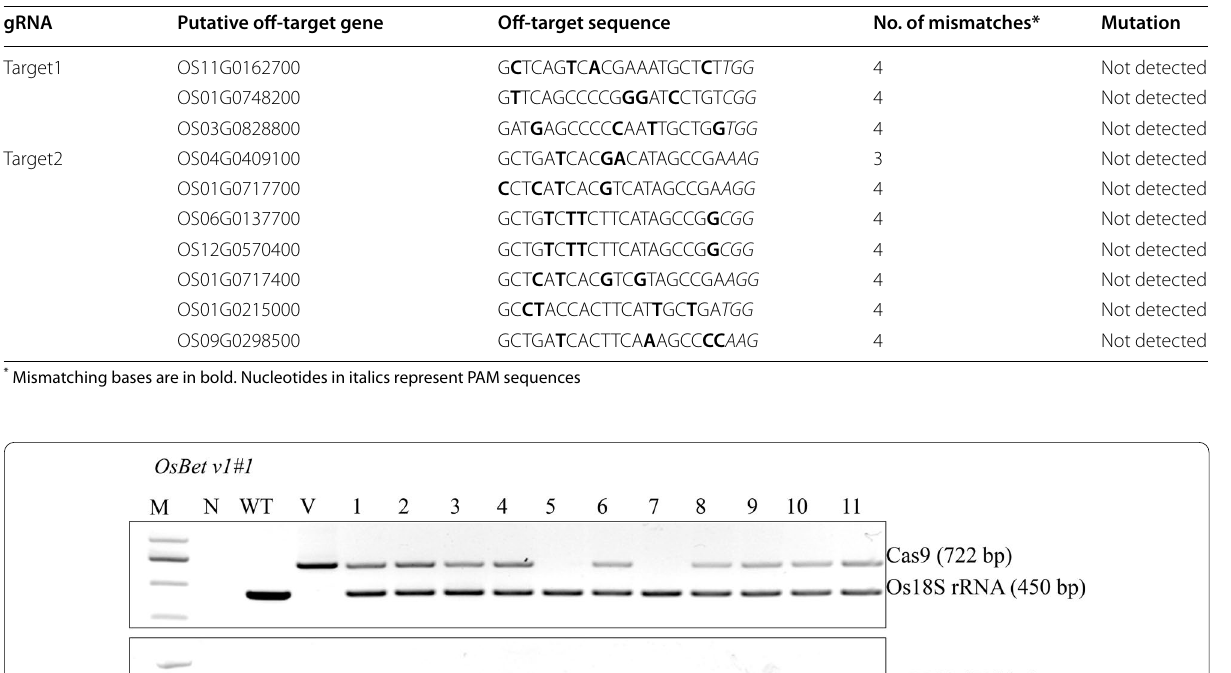
Table 1 Detection of the putative off-target effect in potential off-target sites of the rice mutants gRNA